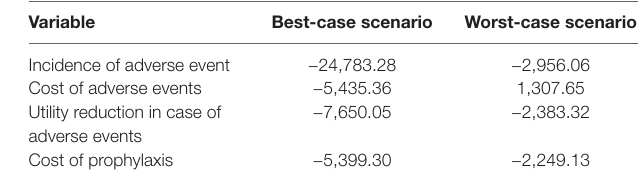
TABLE 5 | Incremental cost-effectiveness ratio for best- and worst-case scenarios (variables with the highest impact in the univariate sensitivity analysis).